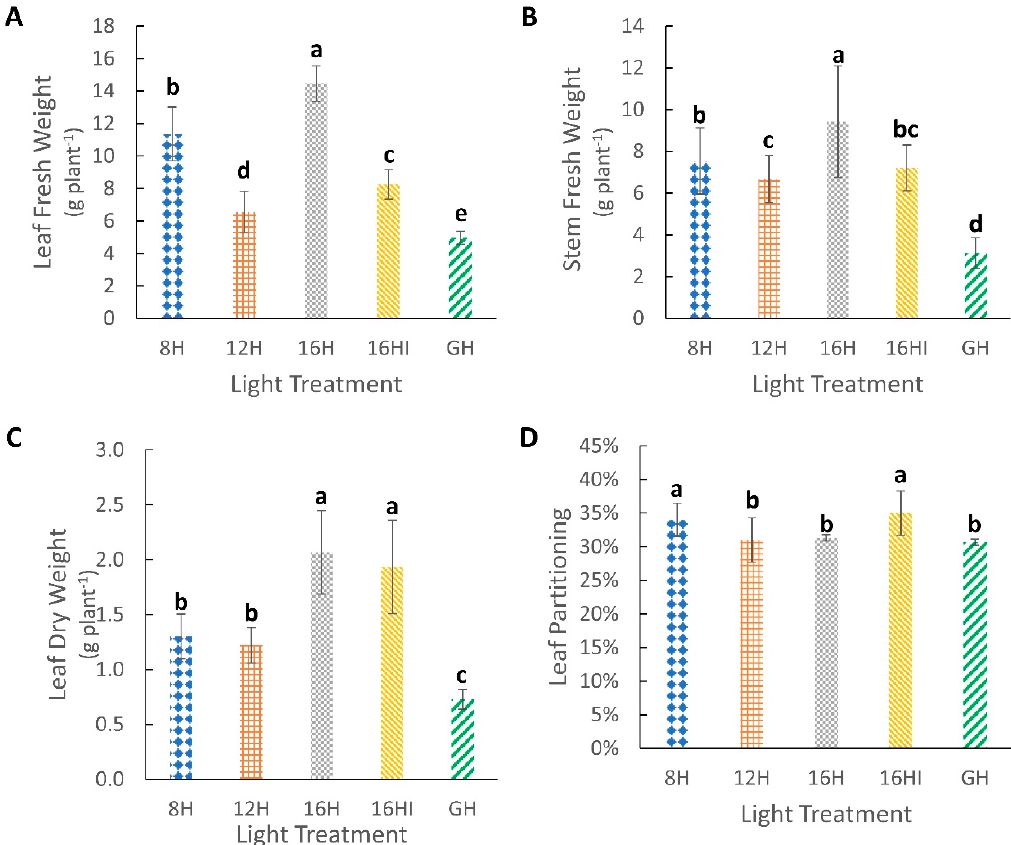
Figure 3. Effect of photoperiod on fresh and dry biomass. ( A ) Leaf fresh weight (g plant − 1 ). ( B ) Stem fresh weight (g plant − 1 ). ( C ) Leaf dry weight (g plant − 1 ). ( D ) Percentage dry biomass partitioning towards leaves (%). All measurements were obtained at 175 DAP. Values represents Mean (n = 72) ± Standard Deviation. Different letters above the error bars indicate statistical significance determined by Tukey’s HSD post hoc test at p < 0.05.